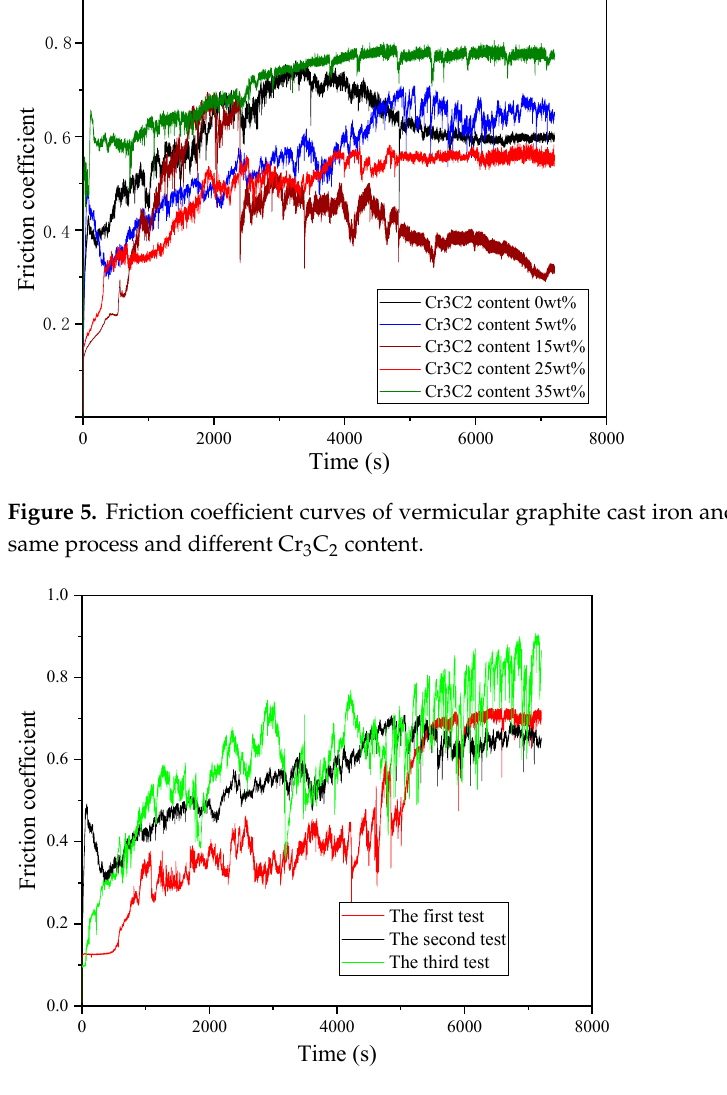
Figure 6. Repeated-test friction coefficient curves of 5 wt.% Cr 3 C 2 cladding layer.